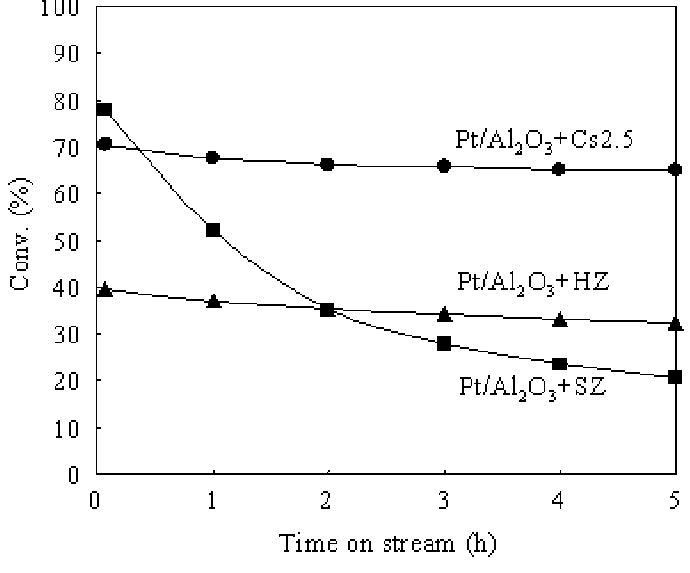
O +Cs2.5, ( ■ ) Pt/Al 2 3